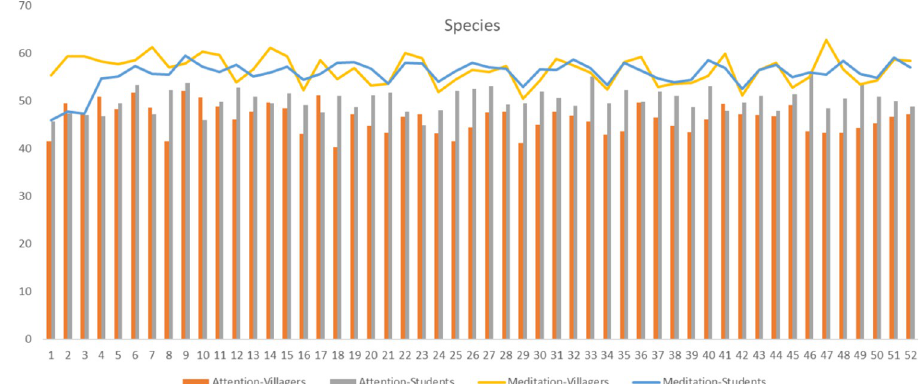
Fig 9. The average value of EEG indicators of villagers and students in different species. 1–52 respectively correspond to the species in Table 1.